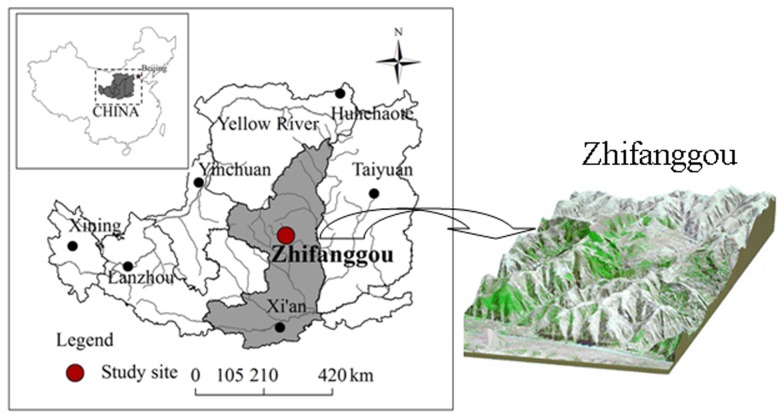
Location and DEM model of the Zhifanggou watershed (adapted from Wang et al., 2011).